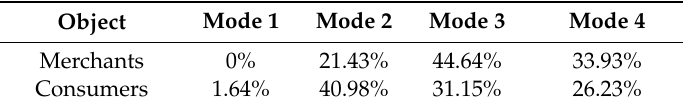
Table 1. The preferences of the first-round modes.